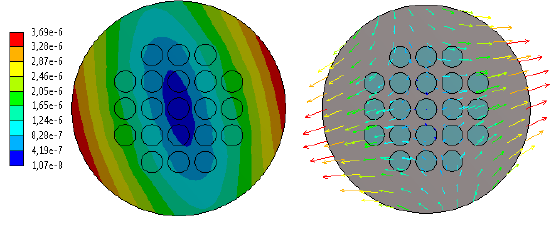
Fig. 9. Total displacements ( m ).